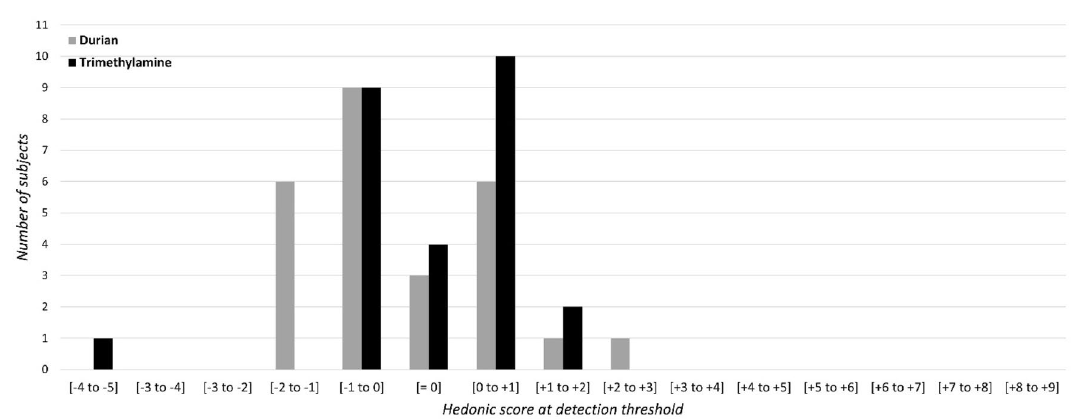
Figure 3. Hedonic scores at IDT for unpleasant odors: number of subjects for each score range (e.g., [− 2 to − 1] means that OHR is comprised between − 2 and − 1). OHR were assessed on a visual analog scale ranging from 0 to + 9 for the pleasant polarity and from 0 to − 9 for the unpleasant